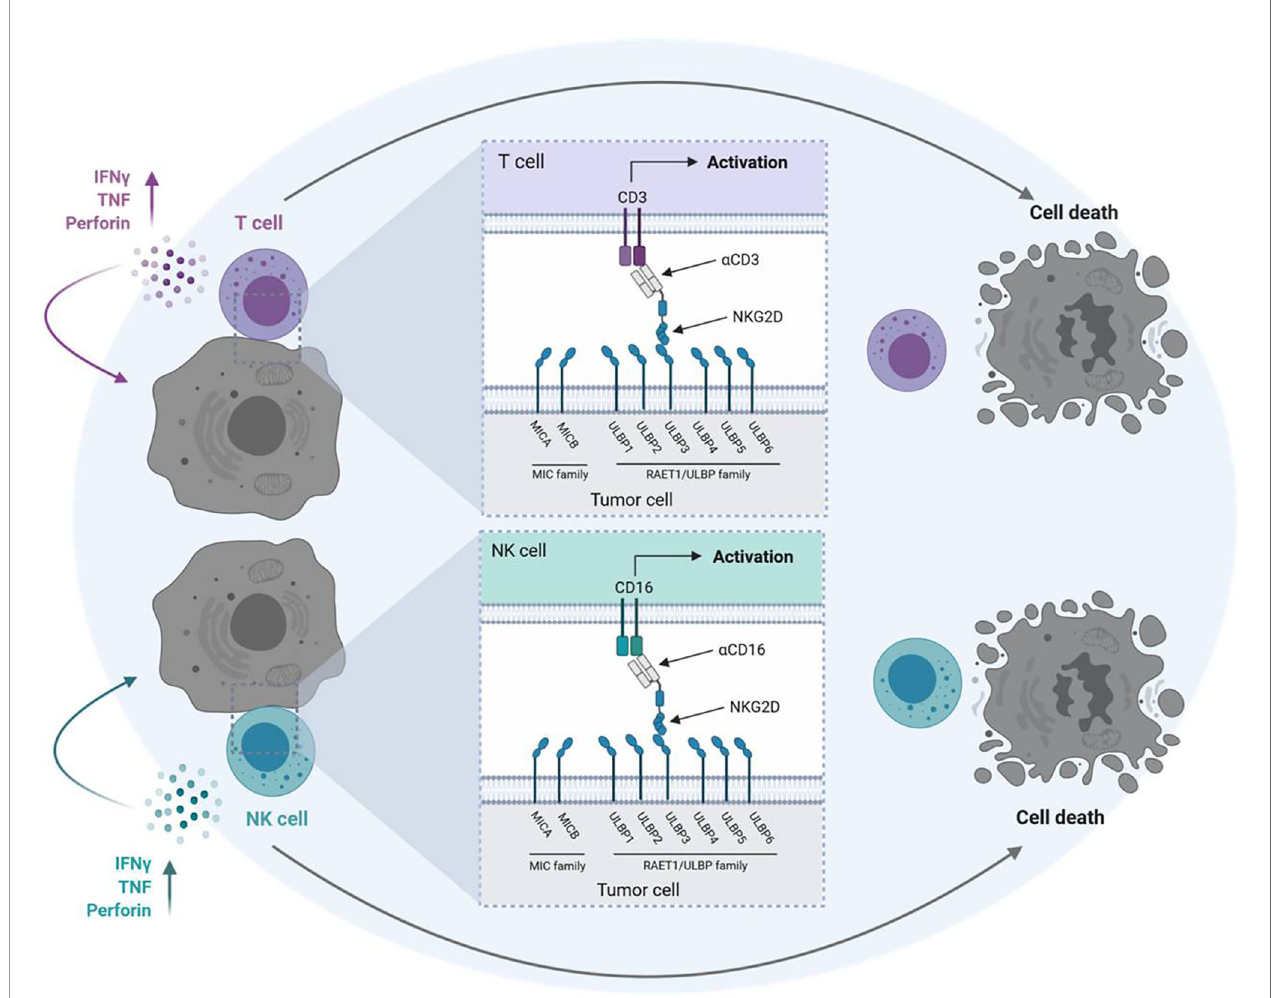
FIGURE 1 | Mechanism of action of NKG2D-CD16/CD3 fusion proteins. Schematic illustration of BFP consisting of the extracellular domain of the NKG2D receptor fused to Fab-fragments directed against CD3 (NKG2D-CD3) or CD16 (NKG2D-CD16). Binding of NKG2D to NKG2DL (MICA/B, ULBP1-6) leads to activation of T cells and NK cells via anti-CD3 and anti-CD16 Fab-fragments and subsequent lysis of tumor cells. The graphic was created with BioRender software (BioRender.com, Toronto,